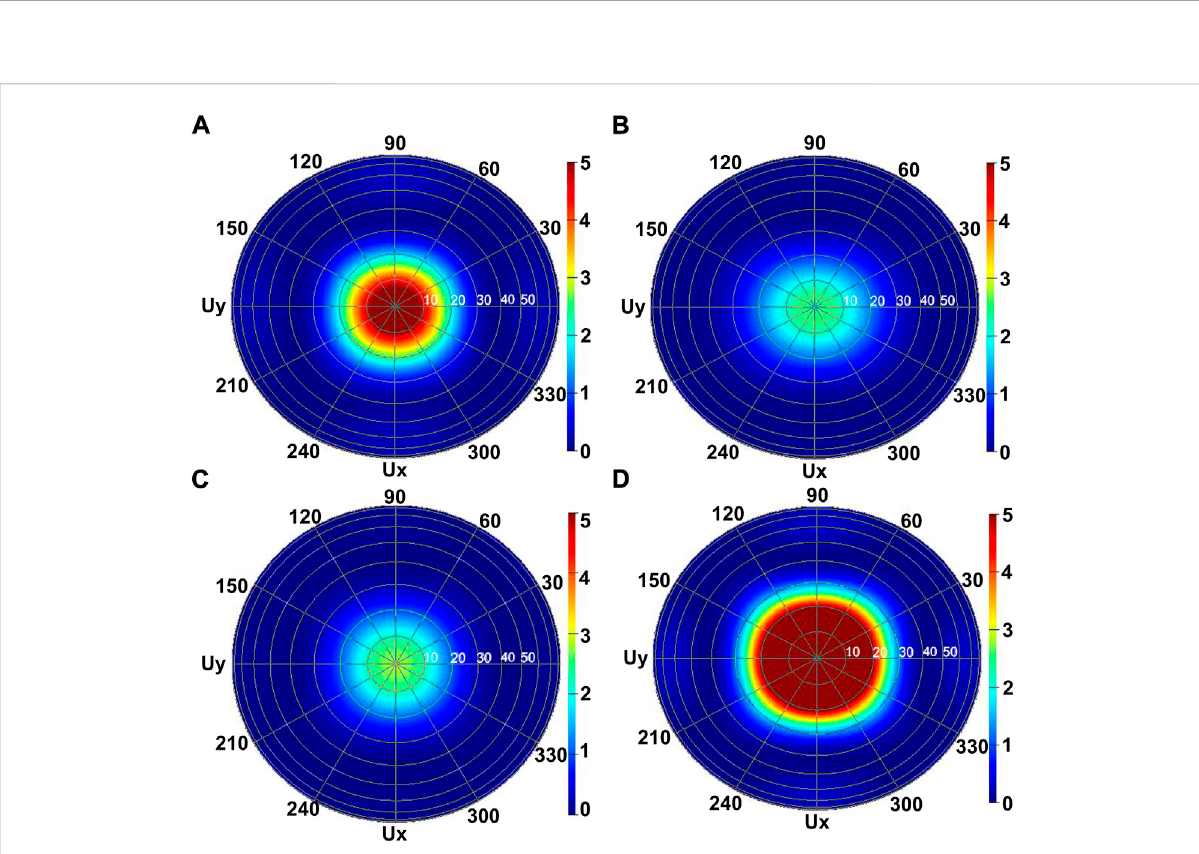
FIGURE 5 (A) and (B) arethefar- fi eldemissionintensitypro fi lesat667 nminrearsidegeometryforthereferenceandsampleB. (C) and (D) arethefar- fi eld emission intensity pro fi les at 667 nm in front side geometry for the reference and sample